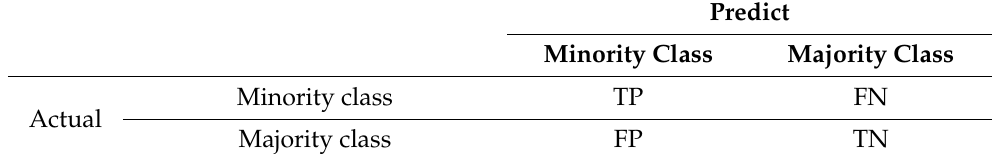
Table 2. Confusion